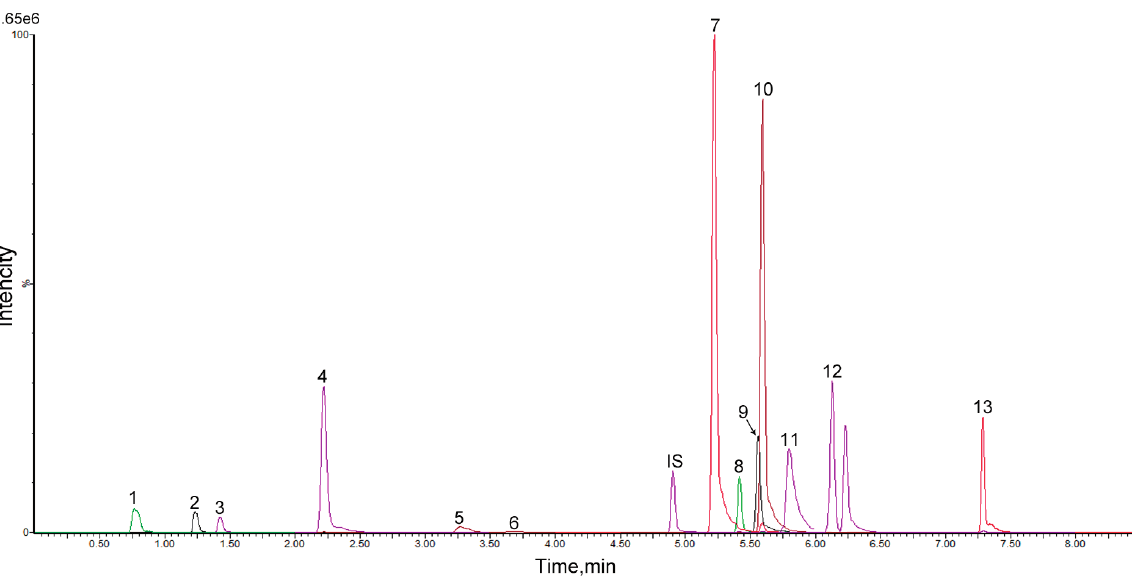
Figure 4. The MRM chromatograms of 13 markers and internal standard: (1) taurine, (2) ginsenoside Rg1, (3) arenobufagin, (4) TDCA, (5) TCA, (6) bufalin, (7) CA, (8) cinobufagin, (9) resibufogenin, (10) ginsenoside Rg3, (11) CDCA, (12) DCA, (13) tanshinone IIA, (IS) astragaloside